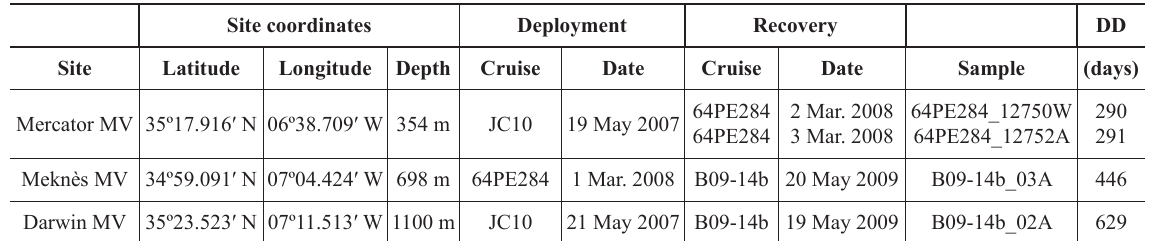
Table 1. Metadata of the deployment and recovery of the colonization experiments in the Gulf of Cadiz. Abbreviations: DD = deployment duration; MV = mud